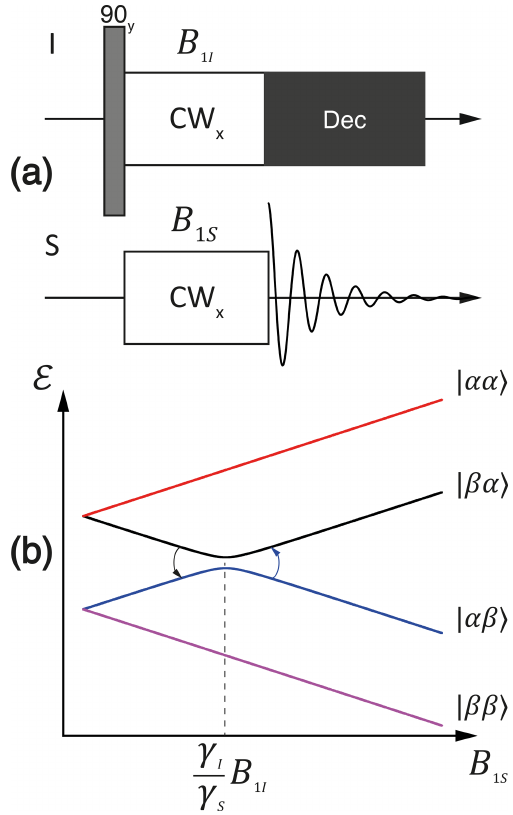
Figure 6. (a) Experimental protocol for the cross-polarization ex- periment. (b) Adiabatic energy levels of the system in the doubly rotating frame. Simulation parameters: I and S nuclei are 1 H and 13 C, respectively; ω = 25kHz; H zz / 2 π = 1 I / 2 π